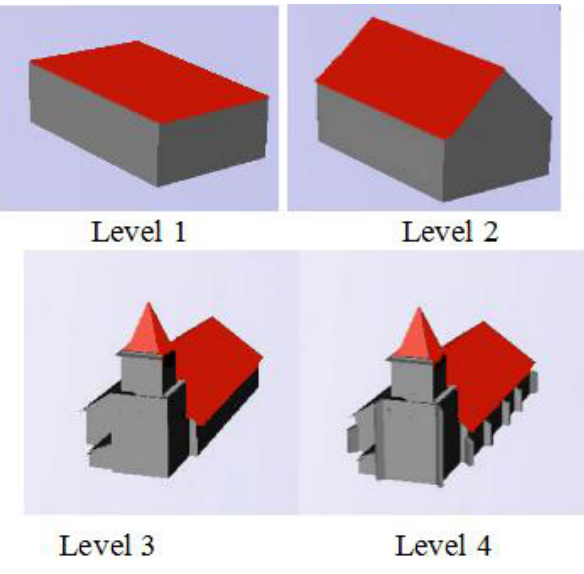
Figure 3. The levels in the CLOD total hierarchical tree.